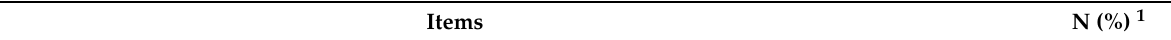
Table 4. Cont. Items N (%) 1 of the relatives was identified (with panic phenomena, lack of cooperation,